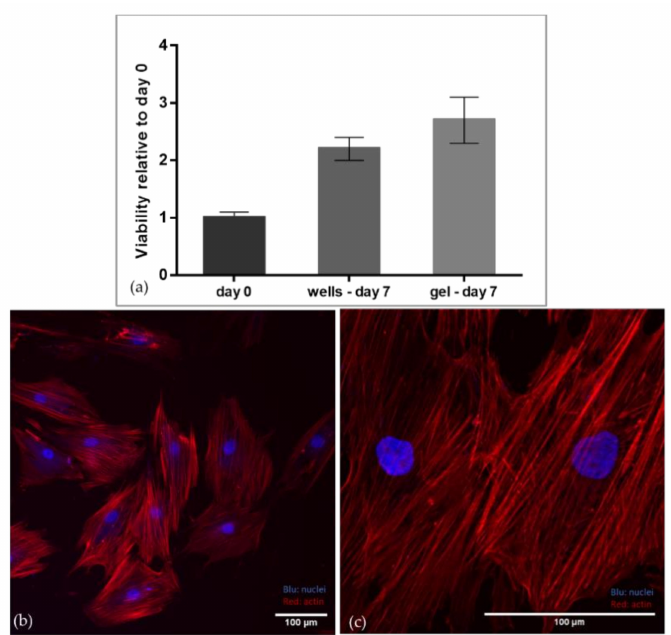
Figure 4. ( a ) Cell viability relative to day 0; ( b ) 20X and ( c ) 20X Nyquist confocal images of aMSC on the mTG-GTA gels after seven days of culture. Nuclei are stained with DAPI (blue) and actin is labelled with Alexa 594-conjugated phalloidin